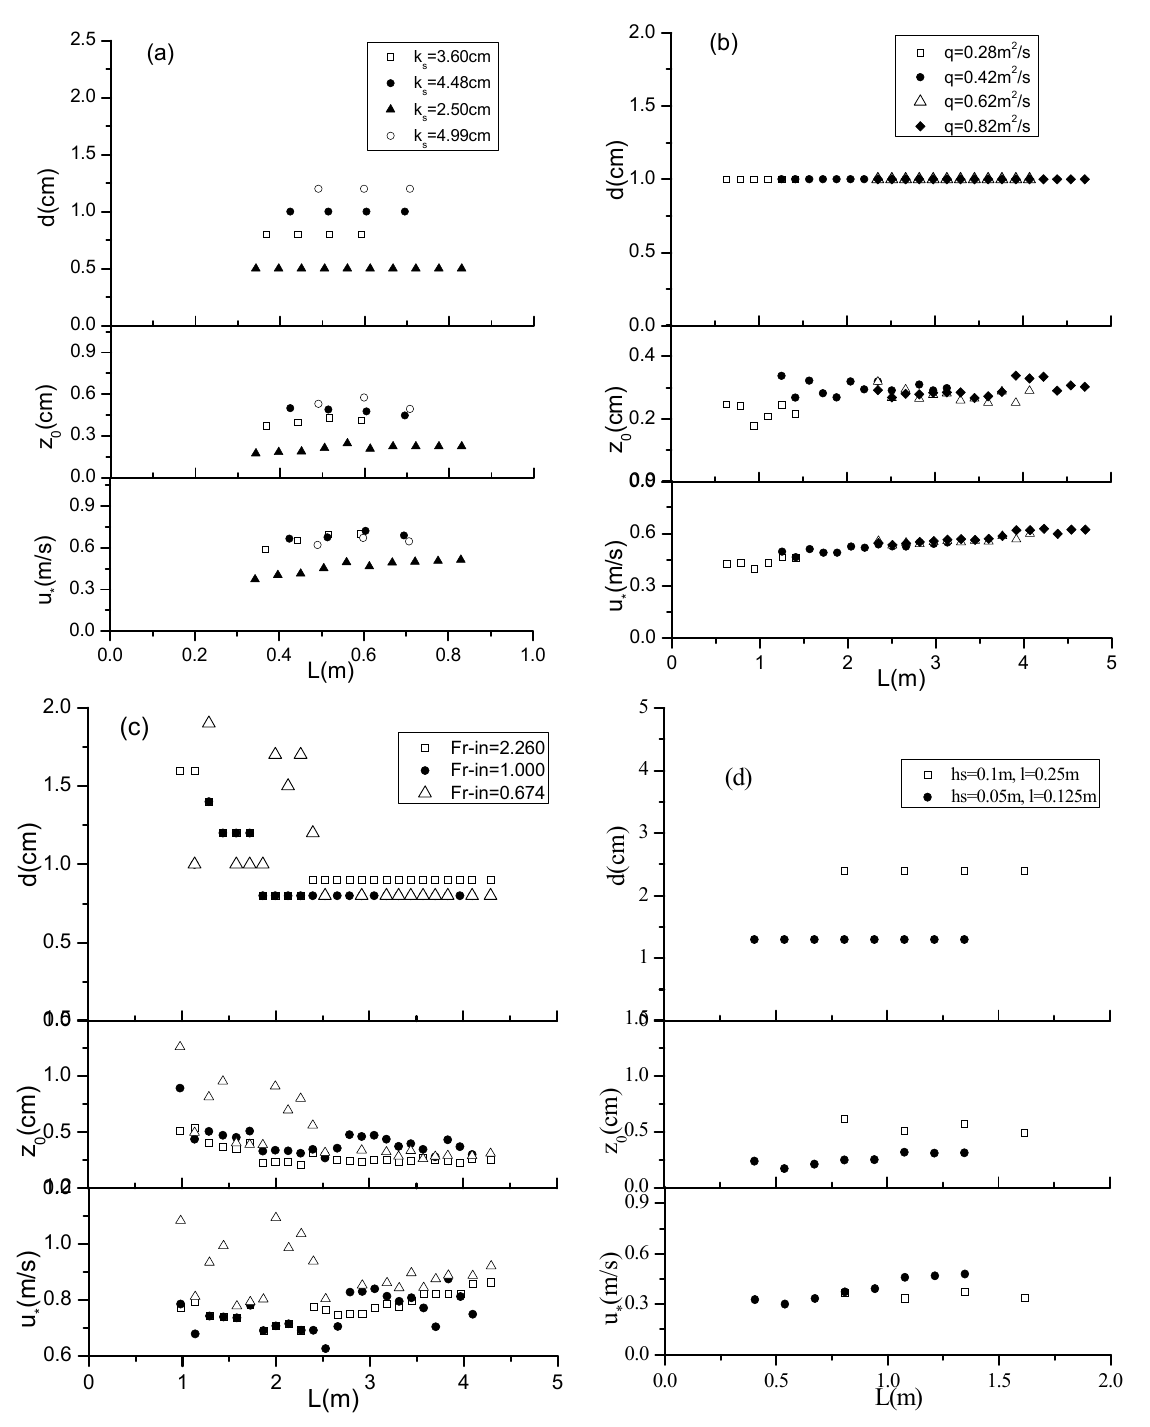
Figure 8. Estimates of d , z 0 and u * for the numerical experiments: ( a ) from run 1, 2, 3 and 4; ( b ) from run 6, 7, 8 and 9; ( c ) from run 12, 13 and 14; ( d ) from run 17 and